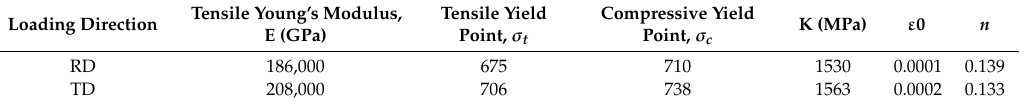
Figure 5. Comparisons of bending moment–curvature diagrams of DP980 under pure bending in the ( a ) rolling direction and ( b ) transverse direction. 3.2. Pure Bending and Springback of Stainless Steel 304 The Voce hardening defined in Equation (7) is fitted to the experimental results in Figure 6. As it can be seen, both tensile and compressive fitted curves were in good agreement with the